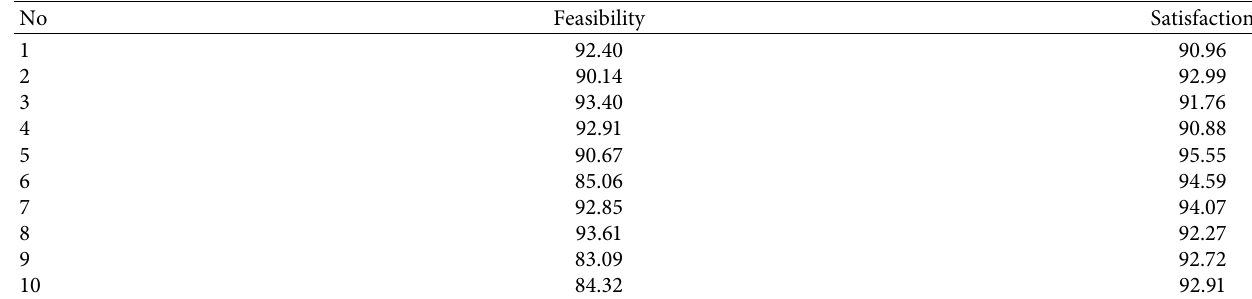
Figure 9: Educational data collection effect and education information management effect. Table 1: System feasibility evaluation and satisfaction